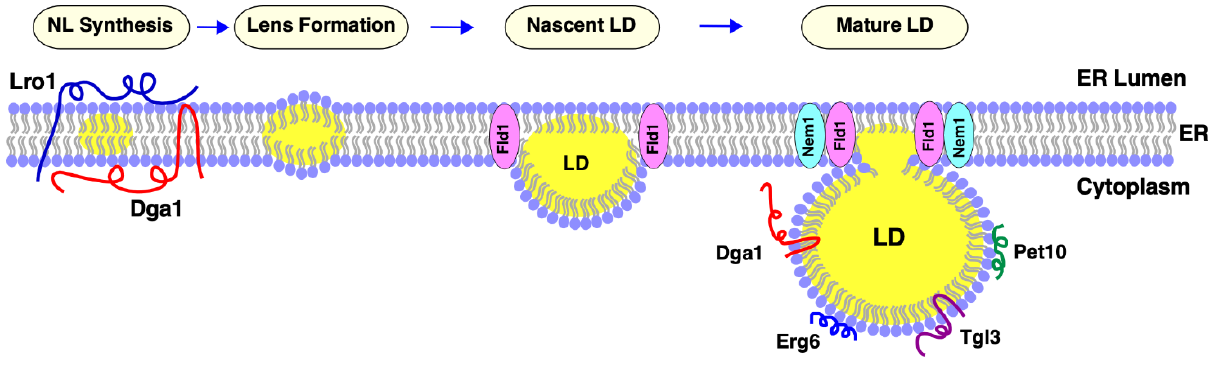
FIGURE 1: LD biogenesis in the ER. ER-localized triacylglycerol producing enzymes, Lro1, and Dga1 catalyze neutral lipid (NL, indicated in yellow) synthesis from opposite sides of the ER membrane. The NL then accumulate between the two-leaflets of the ER membrane leading to formation of lipid lenses. These NL lenses grow in size to become nascent LDs, which then emerge towards the cytoplasm where they further mature. Fld1 and Nem1 proteins show punctate localization at ER-LD contact sites. The acyltransferase Dga1, and the TAG lipase Tgl3 translocate onto the periphery of mature LDs. Finally, LD-marker proteins such as the perilipin ortholog Pet10 and the sterol biosyn- thetic enzyme Erg6 decorate the surface of the mature